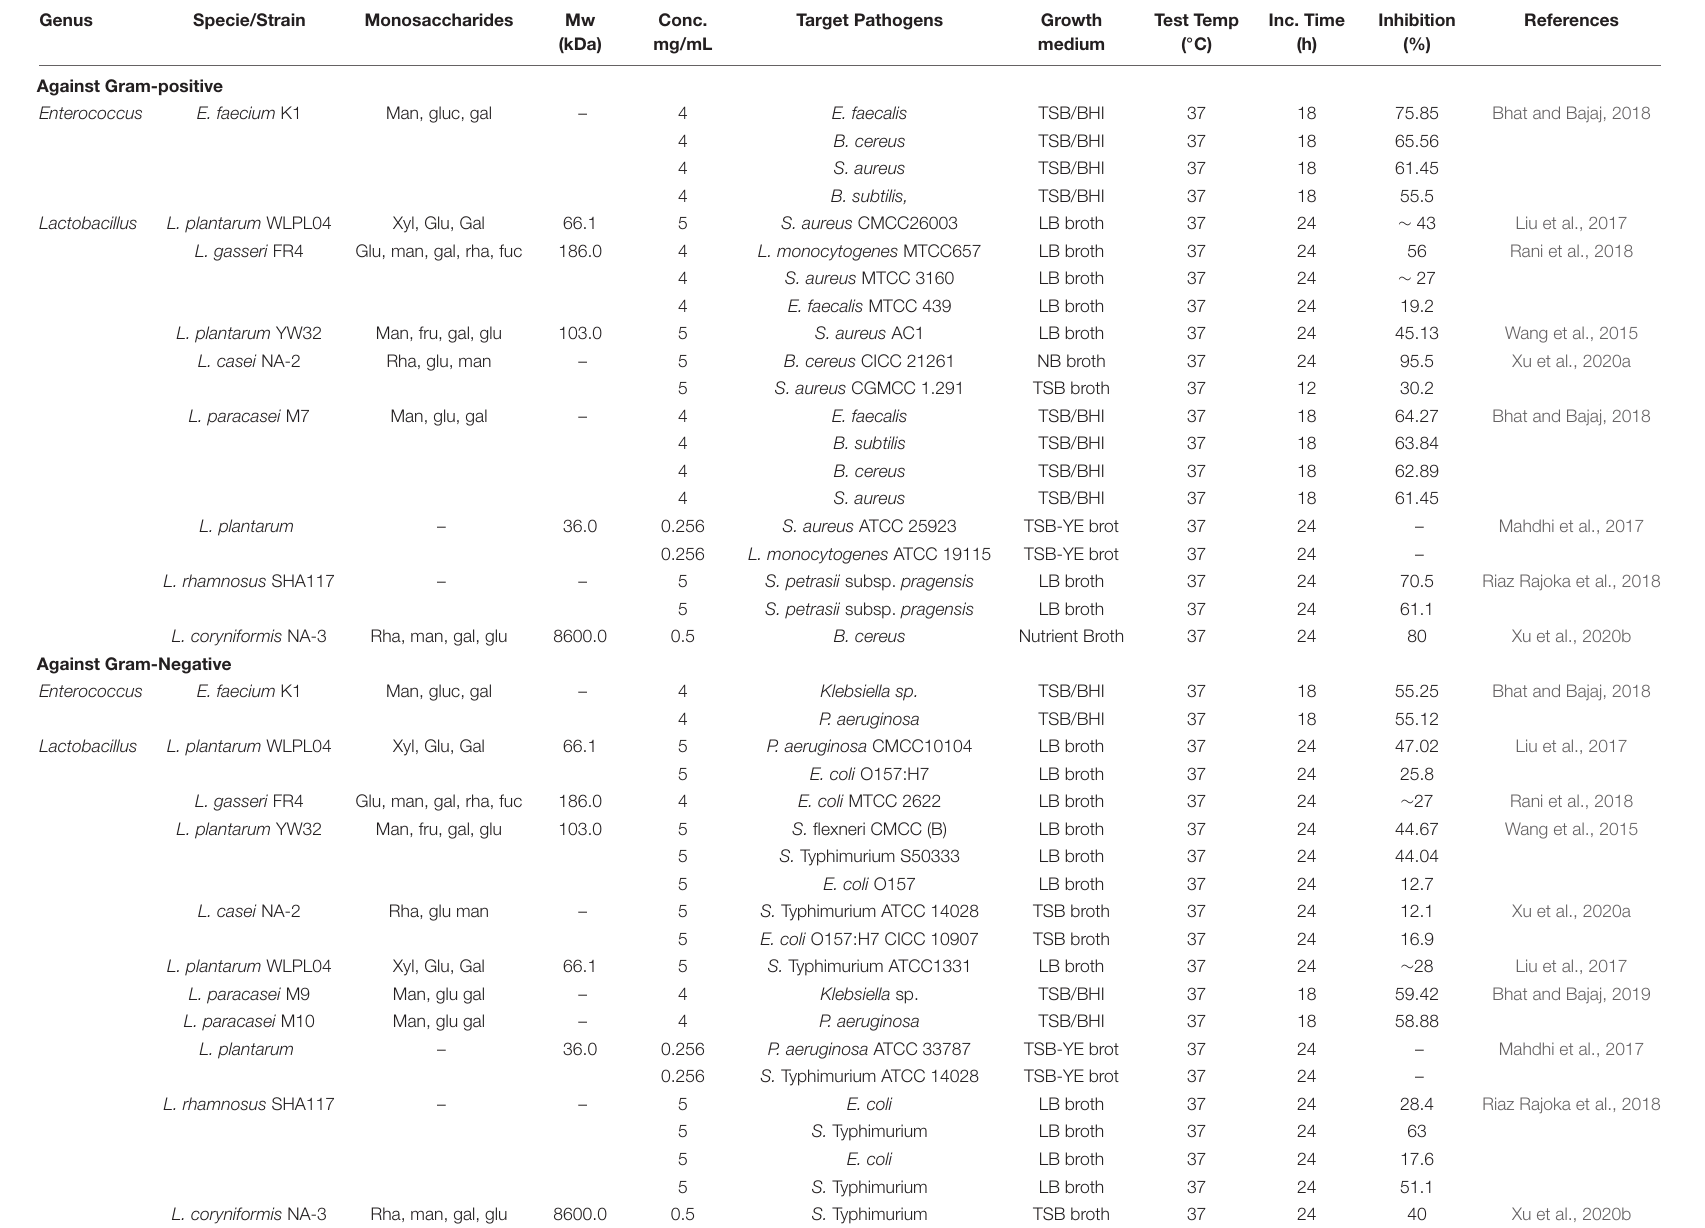
TABLE 3 | Antibiofilm activity of LAB-derived EPS against bacterial